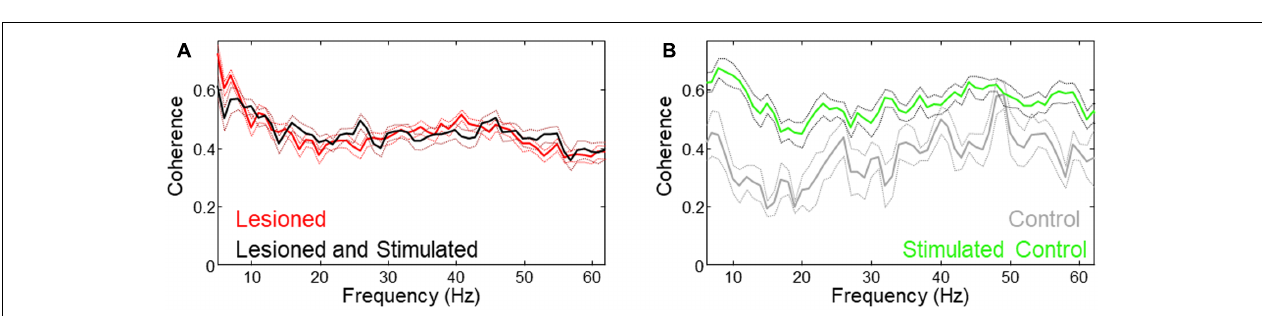
FIGURE 6 | Locomotion speed correlated with M1-LFP signal amplitude in lesioned mice. (A) M1-LFP root-mean-square (RMS) amplitude’ and locomotion speed were increased during stimulation in lesioned mice (boxplots reflect data from each minute in a representative 5-min trial). (B) M1-LFP RMS amplitude was increased and locomotion speed was decreased in unlesioned control. (C) M1-LFP RMS amplitude vs. mean locomotion speed for all trials. Each point represents a 5-min trial. Dashed line indicates a linear fit to the points for the lesioned mice.